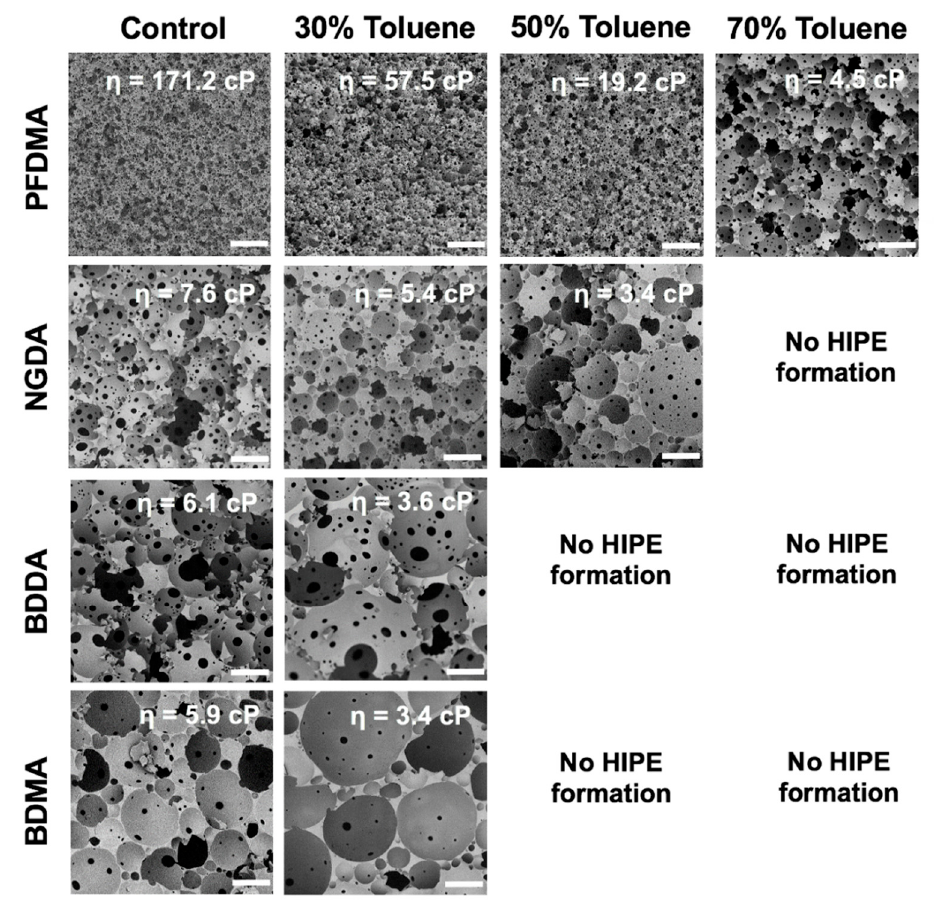
Figure 9. Representative scanning electron micrographs of polyHIPEs fracture planes illustrating the effect of lowering organic phase viscosity with increasing concentrations of toluene on pore architecture. Scale bar is 100 µm.